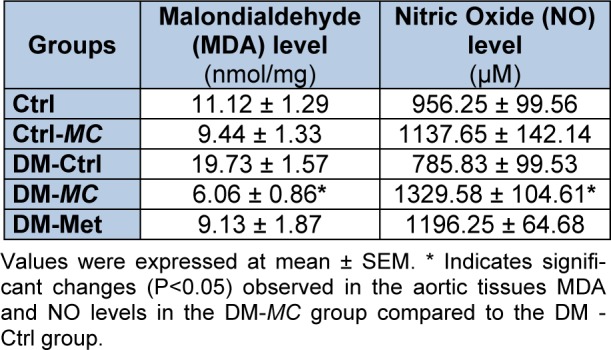
Effect of MC fruit extract on MDA and Nitric Oxide levels in the aortic tissues